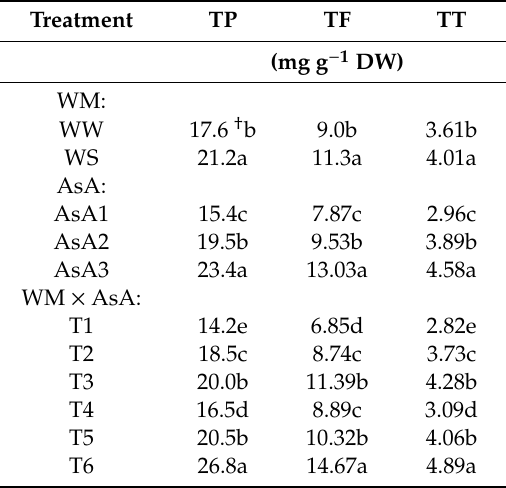
Table 3. The e ff ect of water management (WM) and ascorbic acid (AsA) on total phenolics (TP), total flavonoids (TF) and total tannins (TT) of bean common plants.